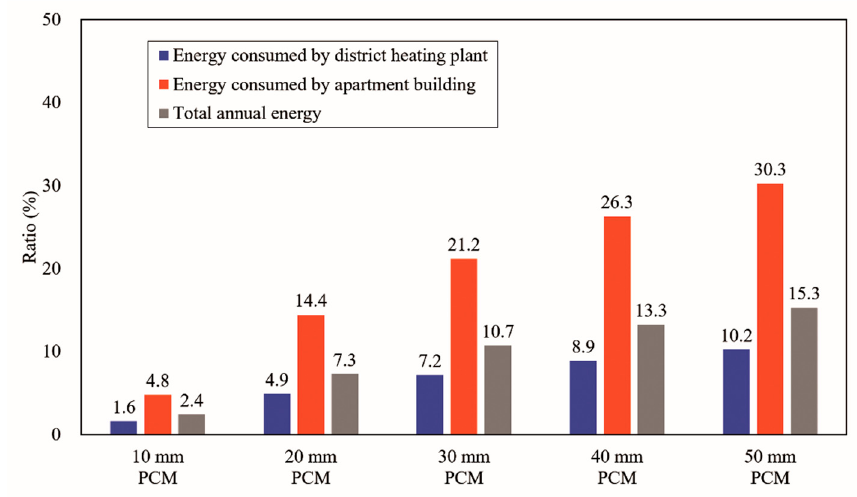
Figure 14. Energy consumptions by the application of 10–50 mm PCM. 306